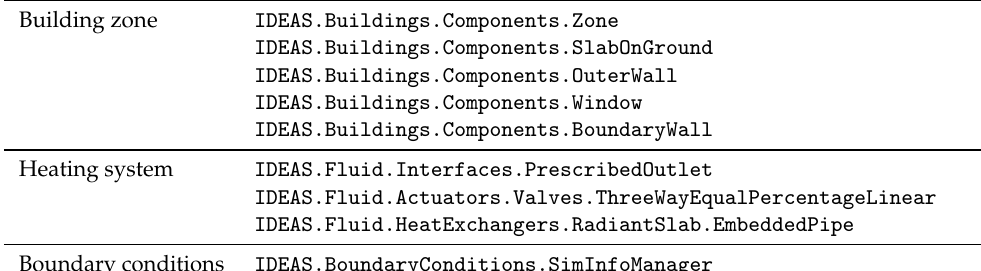
Table 1. Modelica components used for the white-box